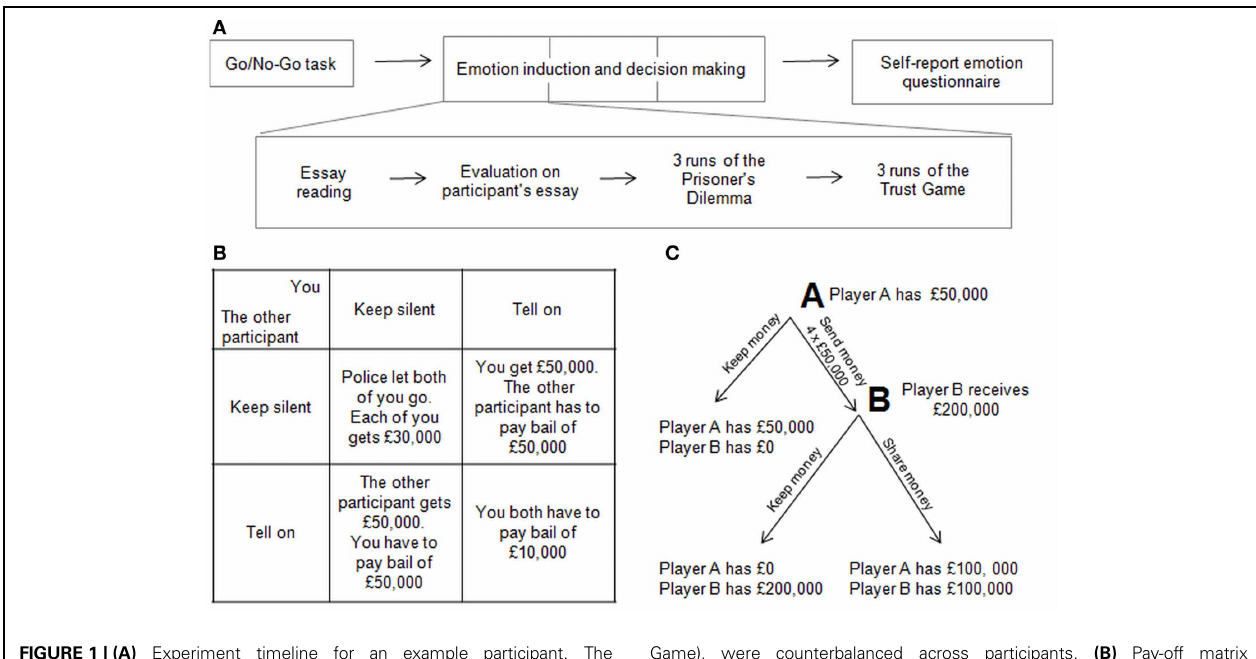
FIGURE 1 | (A) Experiment timeline for an example participant. The order of the three emotion induction conditions, and of the two social-exchange games (the Prisoner’s Dilemma and the Trust